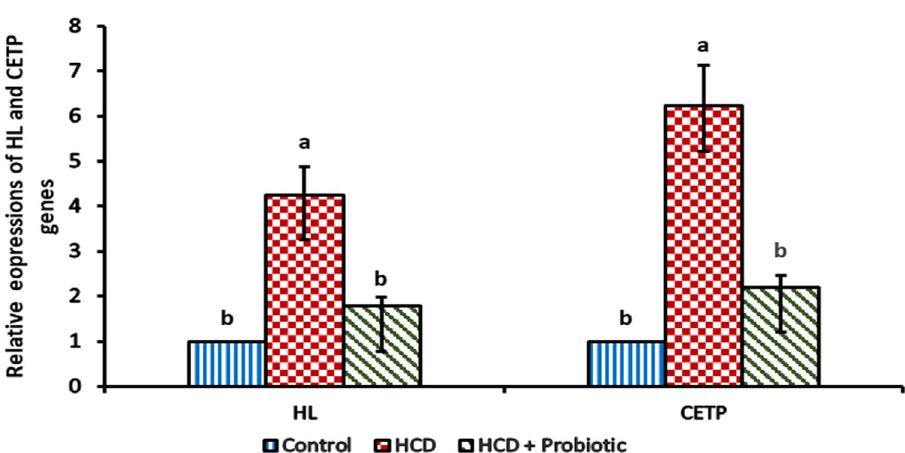
Figure 5. Effect of HCD supplementation and HCD with probiotic supplementation on lipolytic gene expression [Hepatic lipase (HL) and Cholesteryl ester transfer protein (CETP)].